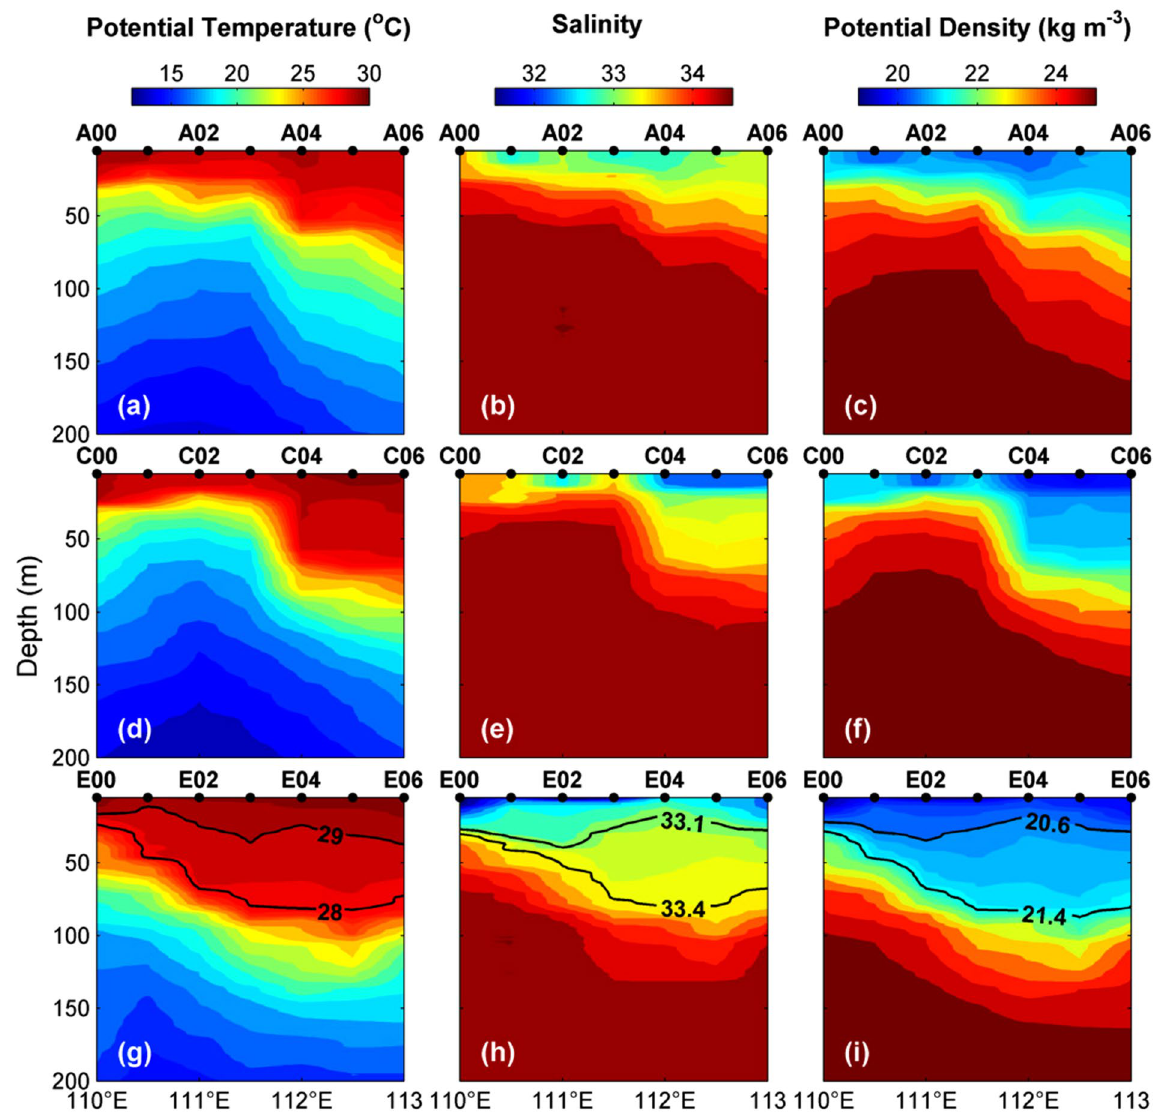
Figure 2. Sectional distributions of thermohaline properties. Potential temperature, salinity and potential density are shown in the left, middle and right columns of panels, respectively. The top, middle and bottom rows of panels are for transects A, C and E, respectively. The figure is generated using Matlab R2011a (www.